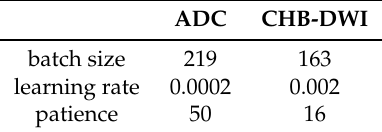
Table 1. Hyperparameters used for data-driven radiomic sequencer parameter discovery.